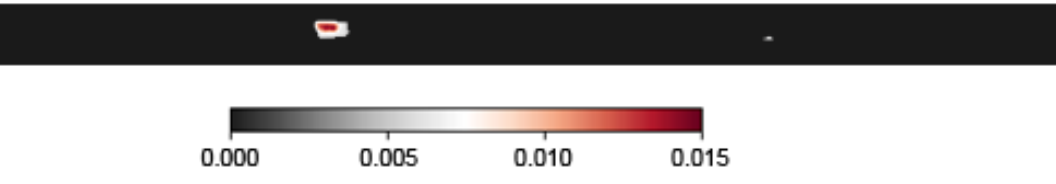
Figure 17. Estimation of local belt defects (values in